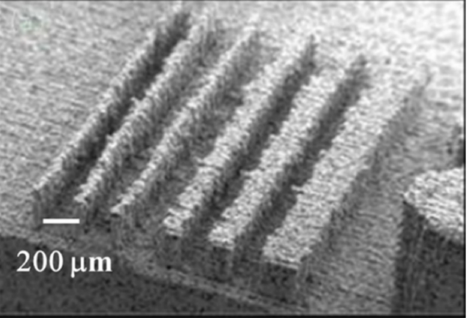
Figure 1. The 316L micropatterns printed by binder jetting (BJ) additive manufacturing technol- ogy